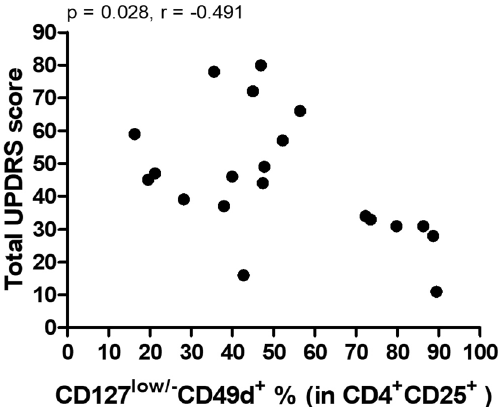
Figure 4. Correlation plot between total UPDRS score and proportion of CD4 + CD25 + CD127 low CD49d +